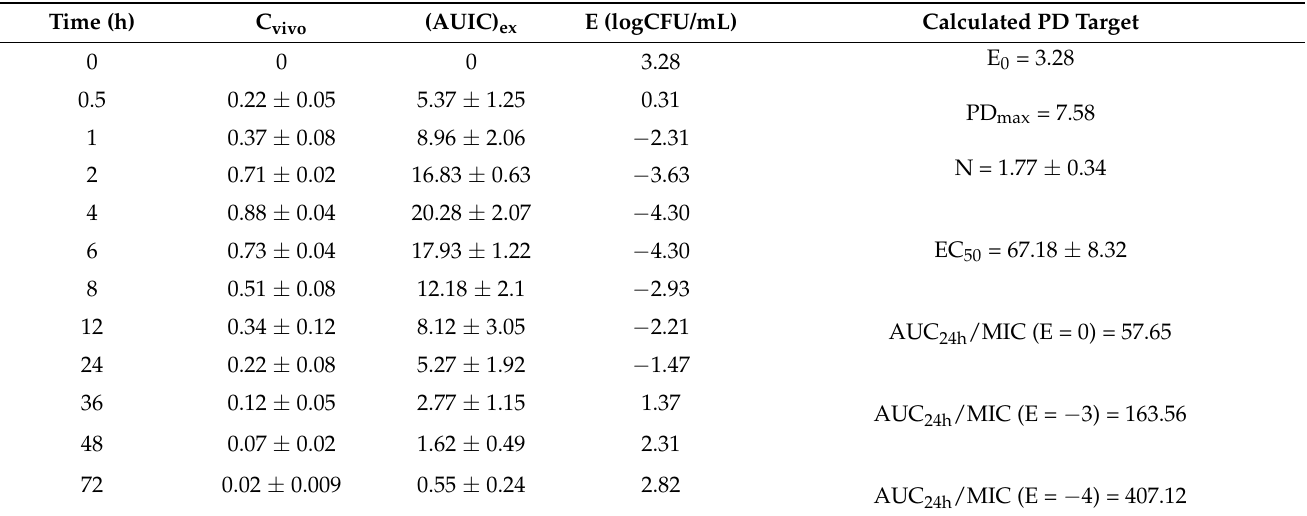
Table 6. PK-PD integration parameters for acetylkitasamycin in PELF after intragastric administration at a dose of 50 mg/kg b.w. ( n = 6).